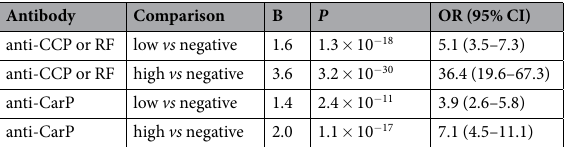
Table 4. Logistic regression analysis of the strength of association of different antibody levels. Each antibody category was analyzed separately with age, sex and EAC as covariates. Low and high categories were defined in relation with the median of the